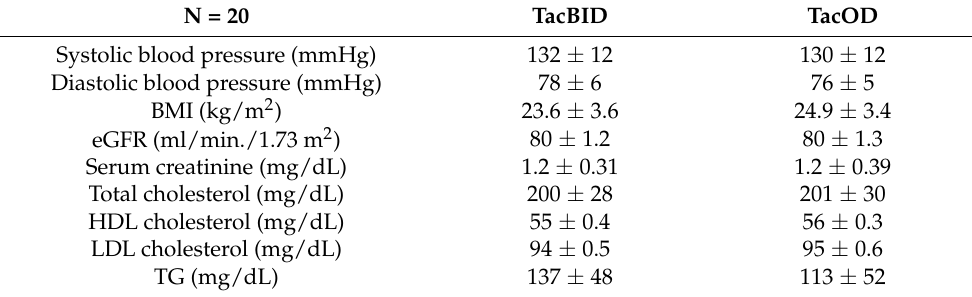
Table 2. Clinical and biochemical data before and after the switch from TacBID to TacOD. N =